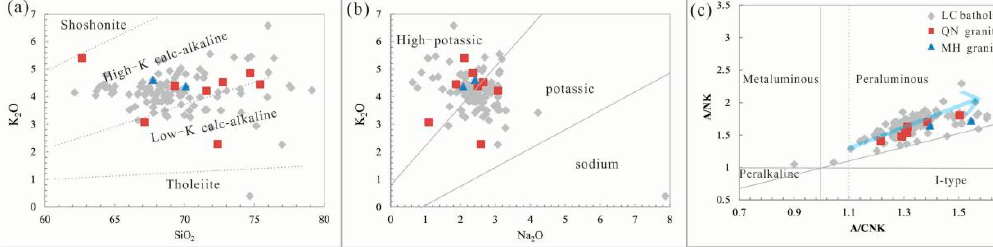
Fig.4 Discrimination diagrams for the Lincang granite